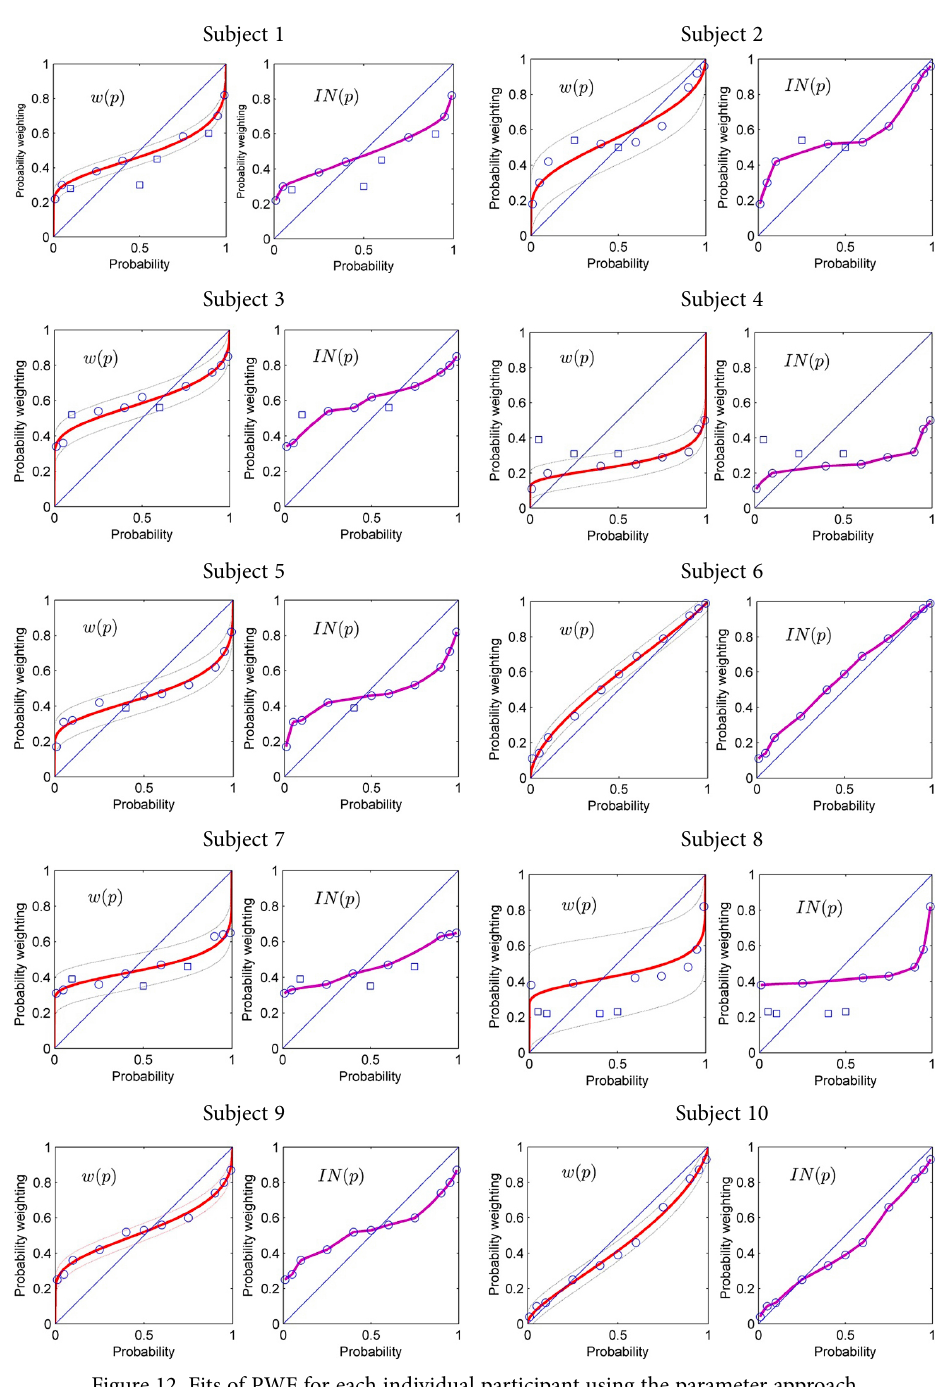
Figure 12. Fits of PWF for each individual participant using the parameter approach and nonparametric numerical